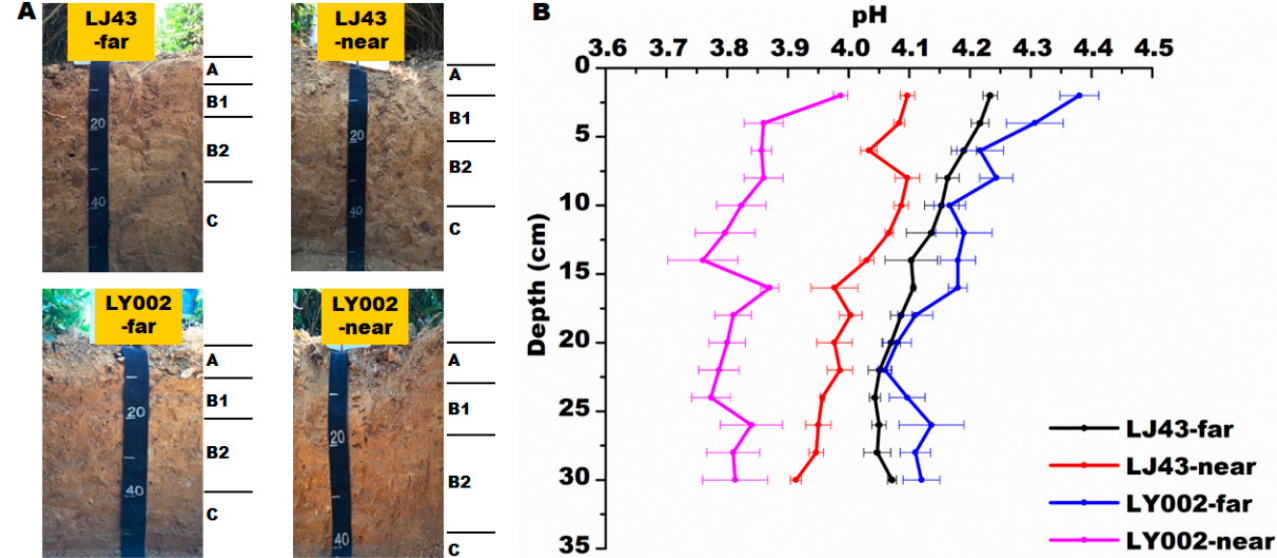
Figure 3. Soil profile and variation in pH of soil related to LJ43 and LY002 with different treatments. Data shows the mean ± standard deviation ( n = 3). A : s oil profile for each treatment; B : variation in pH in each treatment.